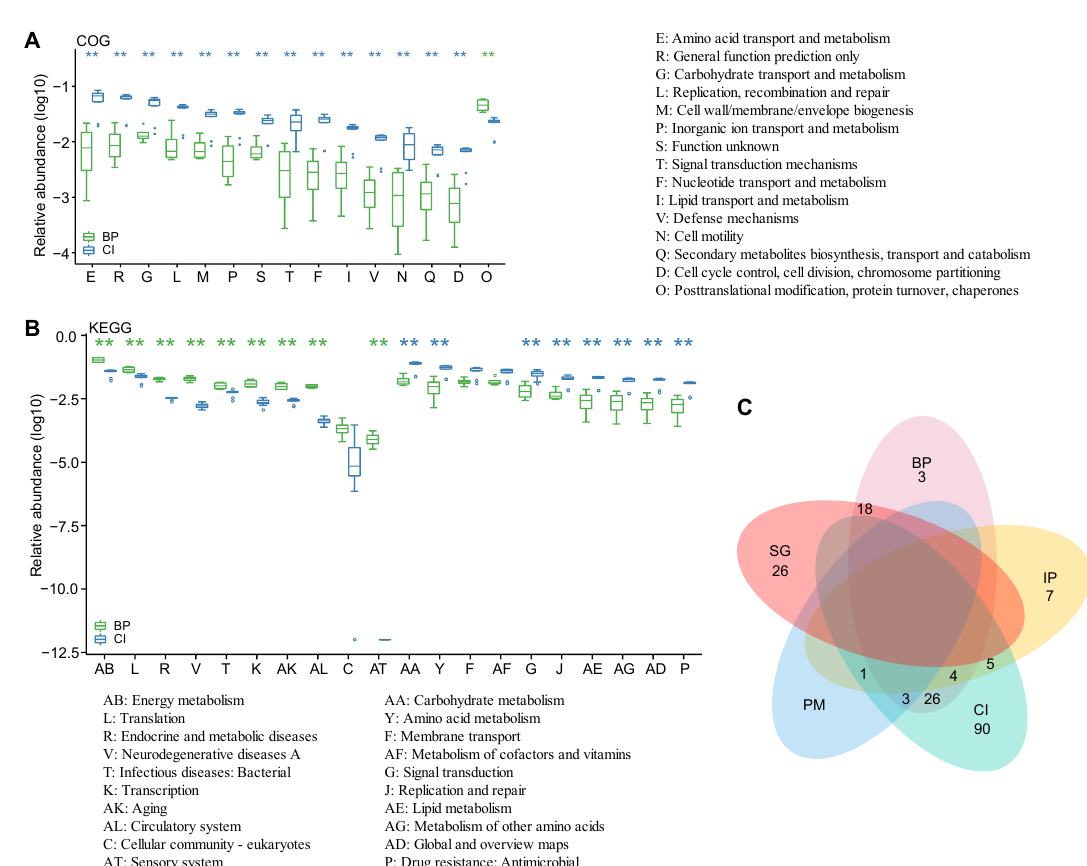
Figure 5. Di ff erential analyses of functional genes. Significant di ff erences in COG ( A ) and KEGG pathways ( B ) were determined between BP and grass carp (CI); ( C ) Venn diagram demonstrating overlaps in bacteriocin-related genes among the examined five common fish species, including blue-spotted mudskipper (BP), giant-fin mudskipper (PM), grass carp (CI), channel catfish (IP), and golden rabbitfish (SG). Significance: * 0.01 < p < 0.05, ** p <